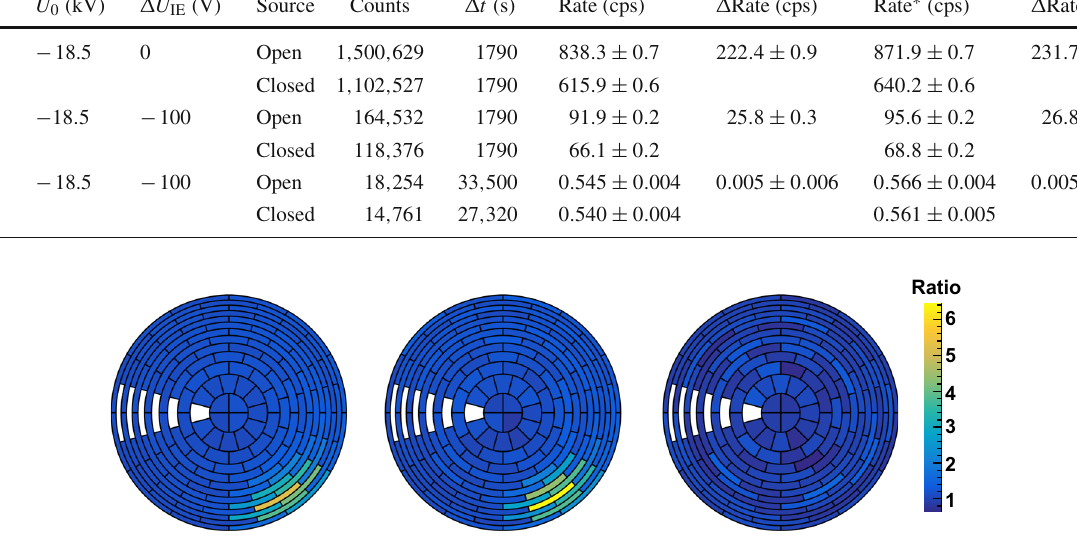
Fig. 6 The ratio of the electron rate with the open 60 Co source to the rate with the closed source, for each detector pixel, for three cases: with nomagneticshieldingandnoelectrostaticshielding(leftpanel),withno magnetic shielding but with electrostatic shielding (center panel), and with both magnetic shielding and electrostatic shielding (right panel).